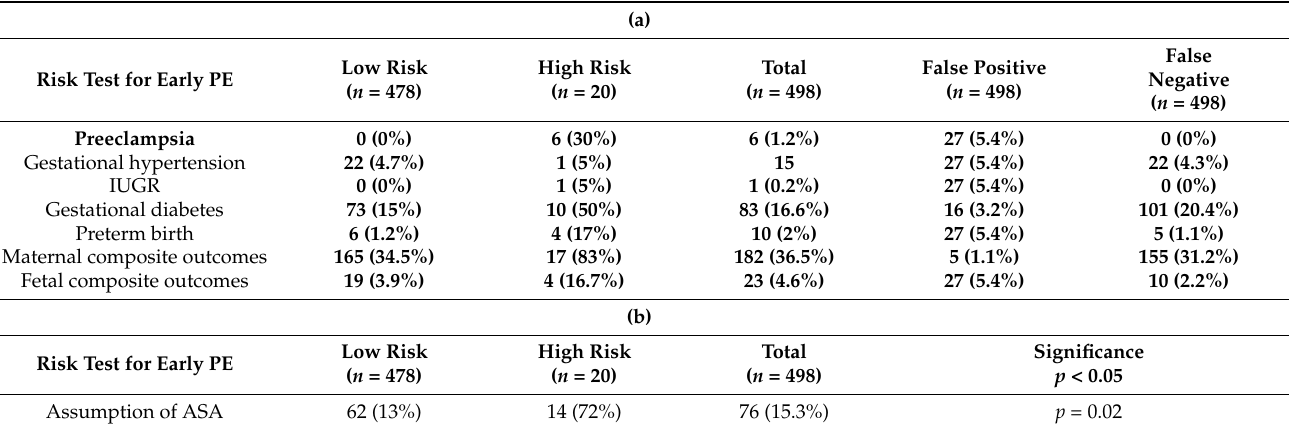
Table 6. (a) Incidence of outcomes in the high-risk population for early PE. (b) Incidence of ASA intake based on early PE risk.